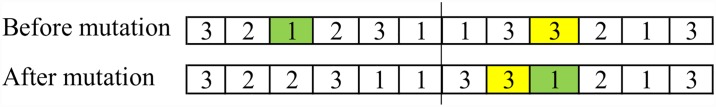
Example of shift mutation operator.